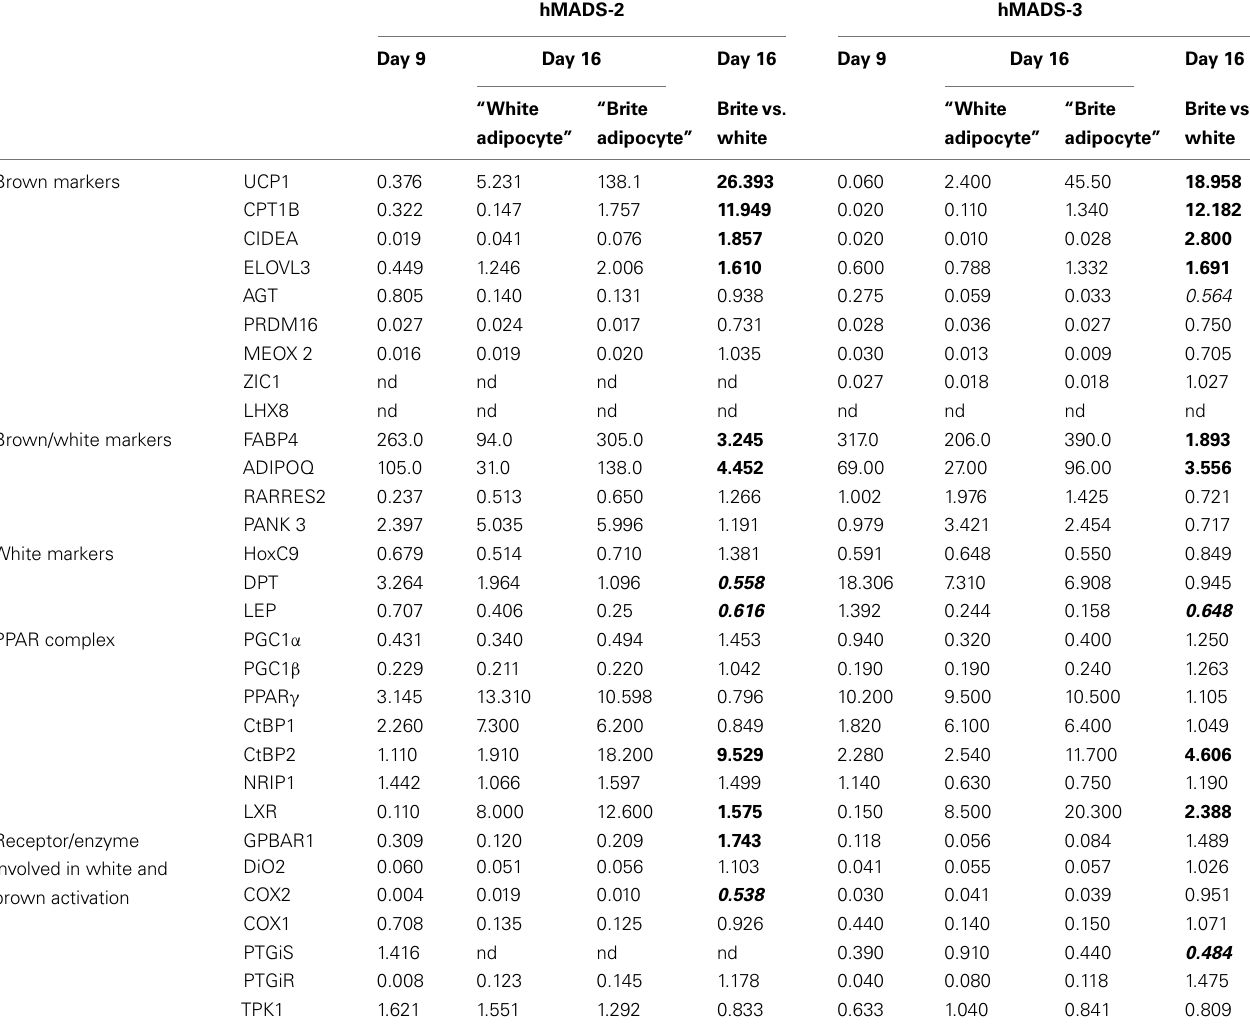
Table 2 |Analysis of white and brown specific markers.